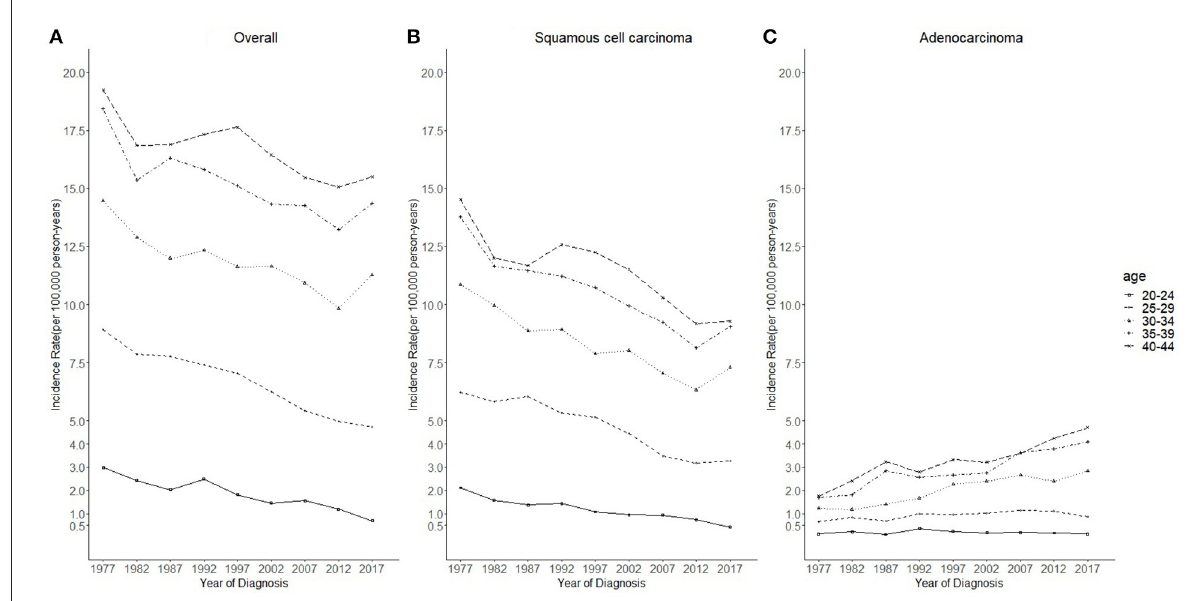
FIGURE2 Temporal trends in cervical cancer incidence rates (1975–2019) among females aged 20 to 44 years by age and histology, United States. (A) Temporal trends of all histopathologic subtypes combined. (B) Temporal trends of squamous cell carcinoma (SCC). (C) Temporal trends of adenocarcinoma (AC). All data are expressed as the rate per